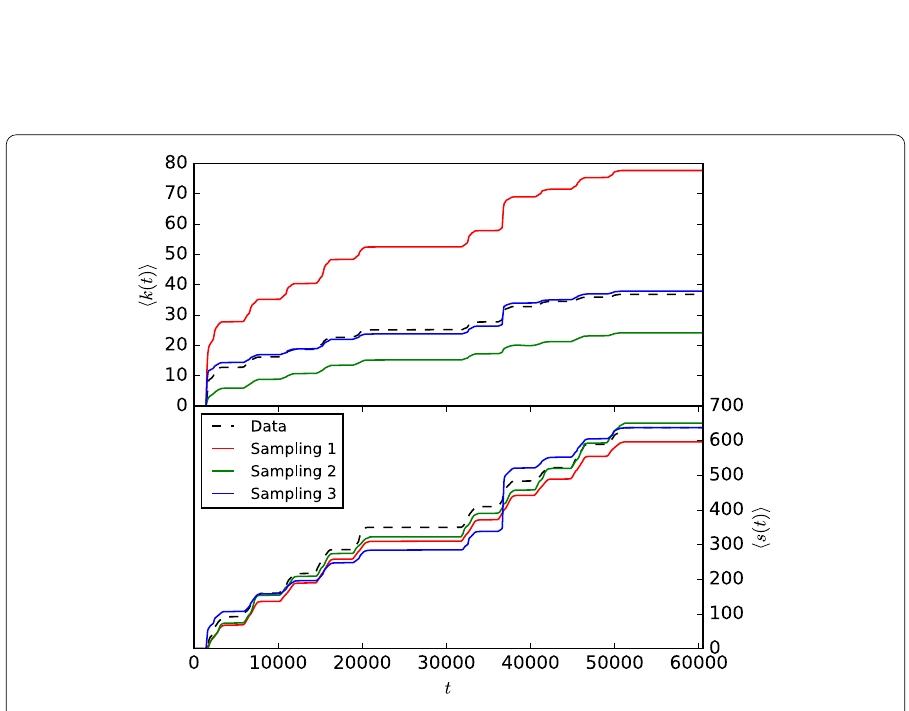
Figure 6 Evolution of the mean aggregated degree and strength. InVS15 data set. We compare how the average degree (cid:4) k ( t ) (cid:5) and the average strength (cid:4) s ( t ) (cid:5) grow as we aggregate the network on increasing time-windows, for the real contact data and each sampling